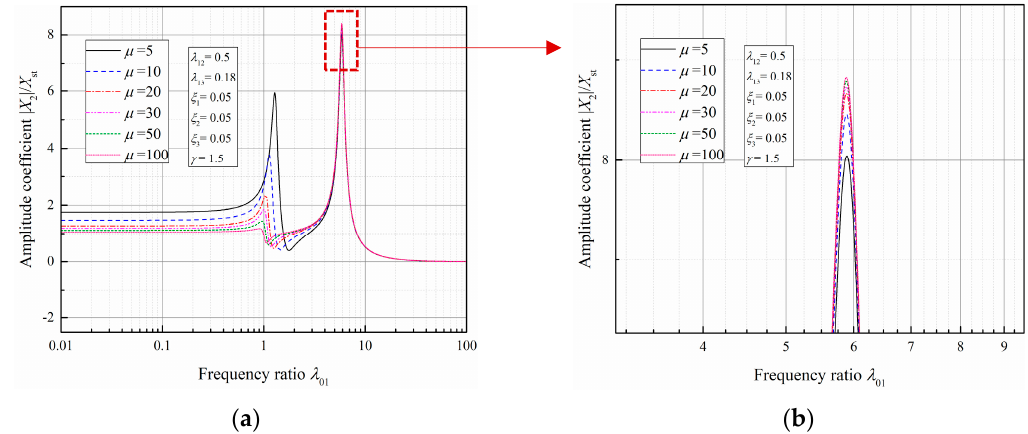
Figure 16. The dynamic response of the accessory structure upon varying the parameter γ . ( a ) The entire graph; ( b ) partial enlarged view of the second peak.